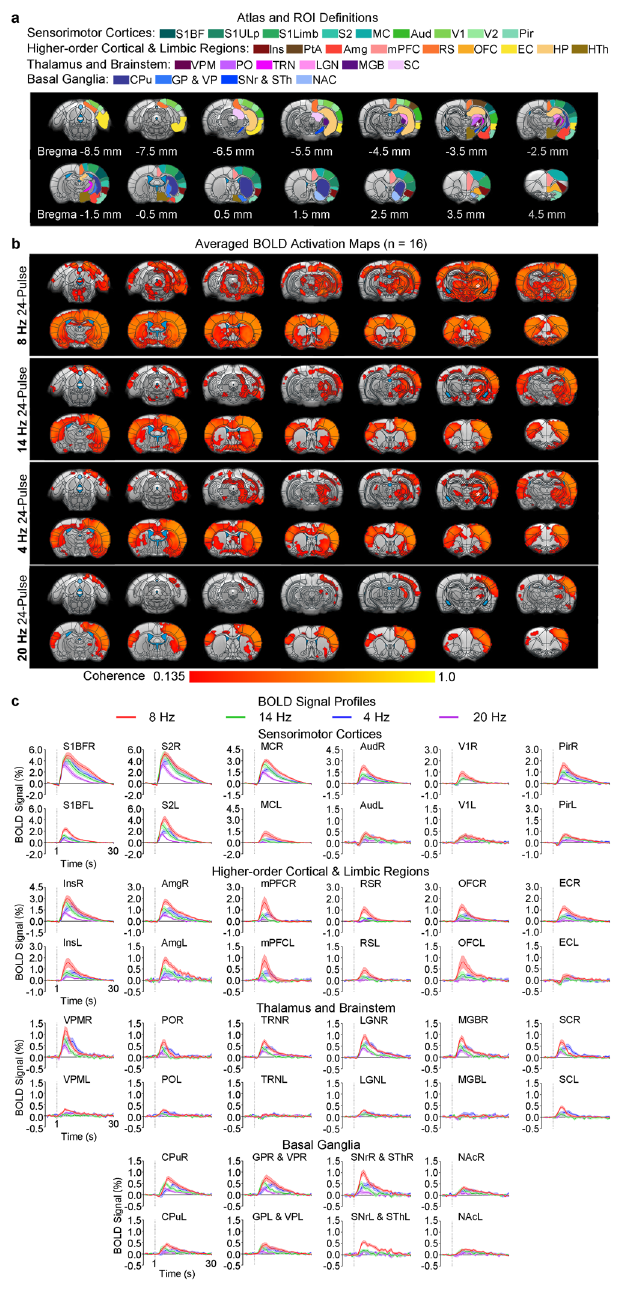
(Fig. S9, activated regions: 14 Hz 24-pulse, MD, mPFC, OFC, RS, S1BF, MC and CPu; 4 Hz 24-pulse, MD, mPFC and MC; 20Hz 24-pulse, MD, mPFC and MC) or length (Fig. S9, activated regions: 8 Hz 16-pulse, MD, mPFC, RS, S1BF, S1Limb, MC, and CPu; 8 Hz 8-pulse, MD, mPFC, MC and GP; 8 Hz 96-pulse, MD, mPFC and MC).